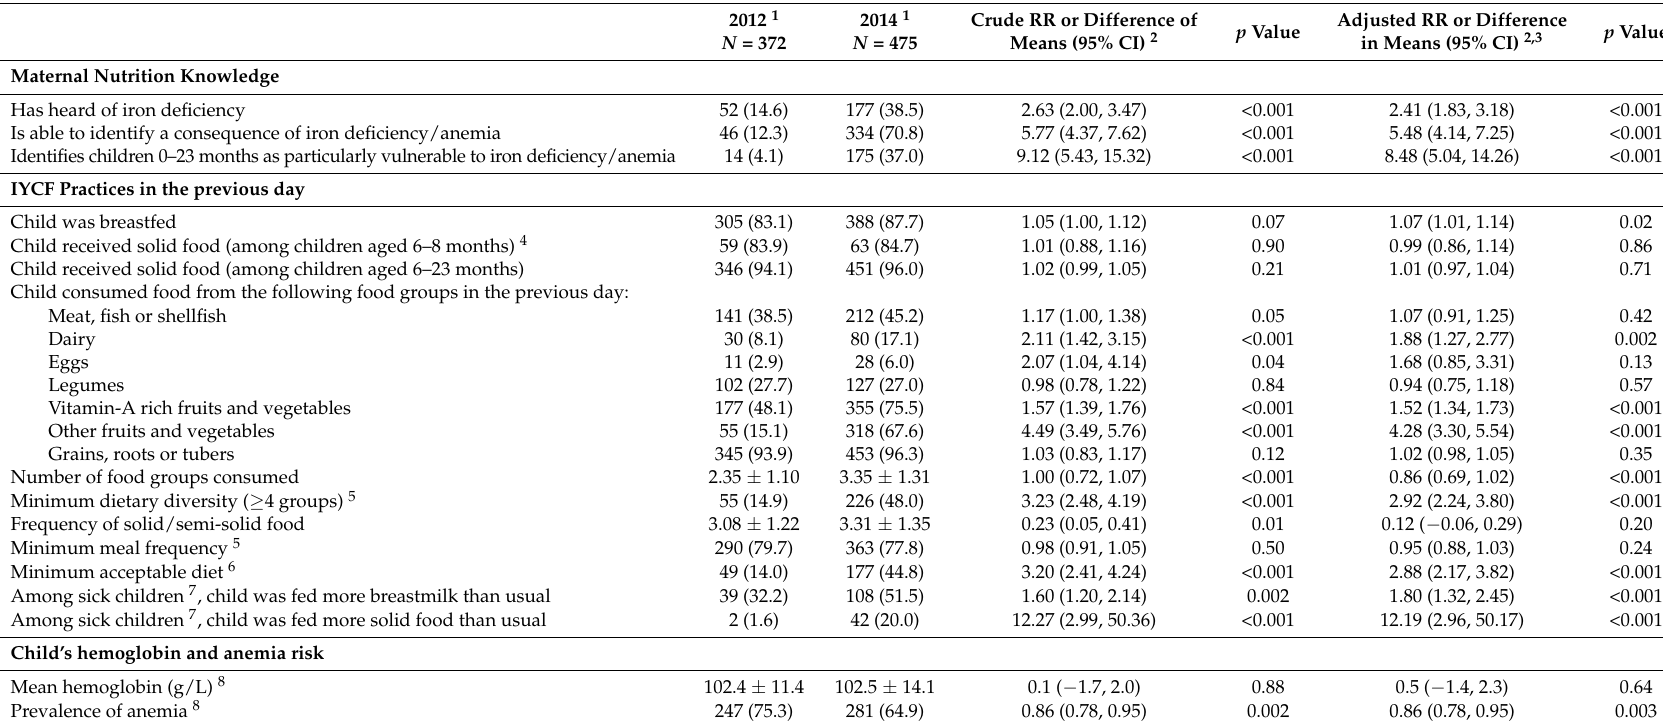
Table 2. Comparing maternal IYCF knowledge and practices, and children’s hemoglobin and anemia risk in households at endline versus